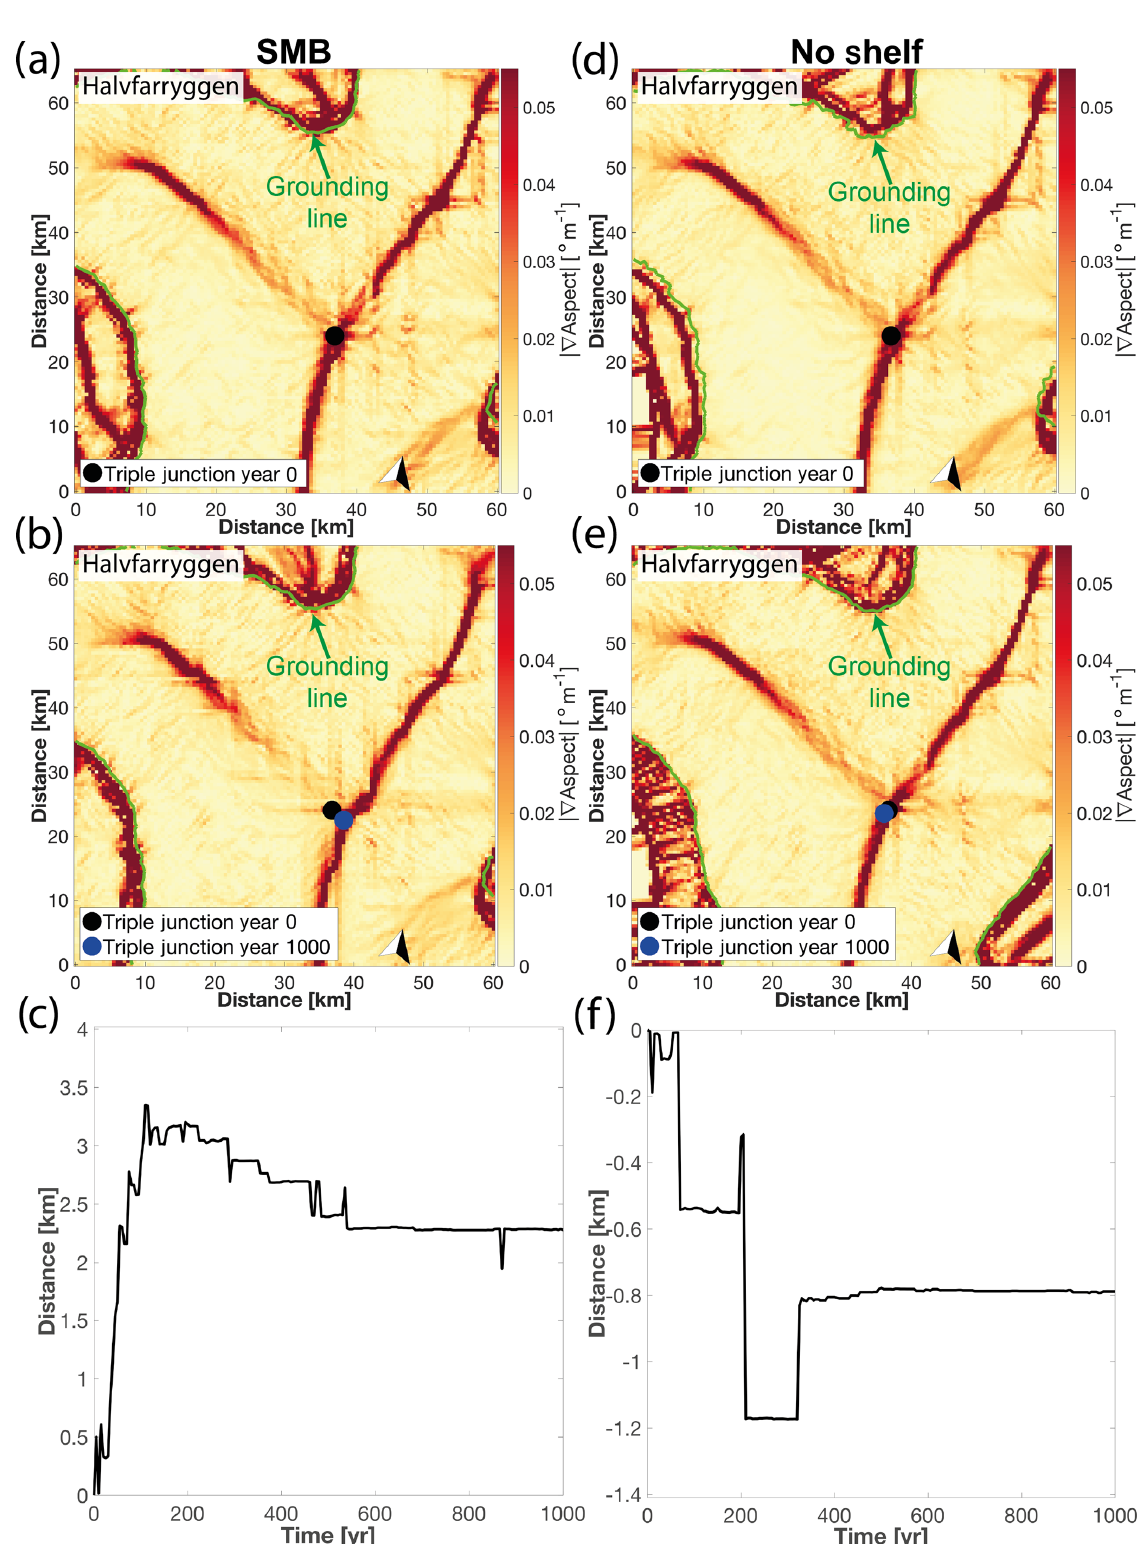
Figure 11. Triple junction migration for the Halvfarryggen Ice Rise induced by ( a – c ) surface mass balance perturbation for the refined mesh and ( d – f ) ocean perturbation (shelf removal) for the refined mesh. Upper and middle panels (a, b, d, e) were regridded onto a 500m Cartesian mesh and show the triple junction position at the start and end of the simulation period, respectively. Lower panel (c, f) shows mean divide migration for the respective perturbation simulations. Negative numbers indicate migration to the west. Note different y -axis scales in (c) and (f)